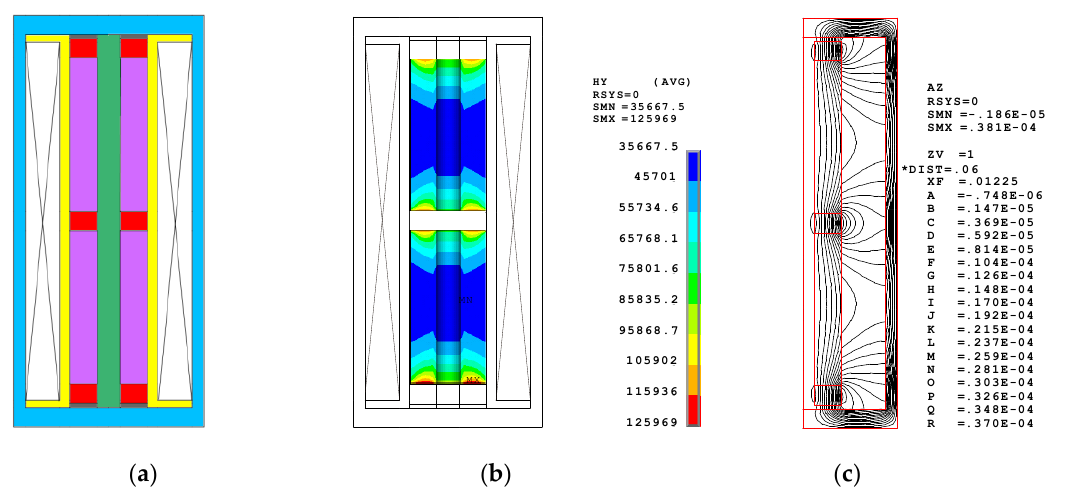
Figure 4. Segmented stack configuration and the finite element simulations. ( a ) The configuration; ( b ) the Bias Magnetic Field Intensity (MFI) distribution; ( c ) the Flux distribution. Table 3. Statistical quantities for the three